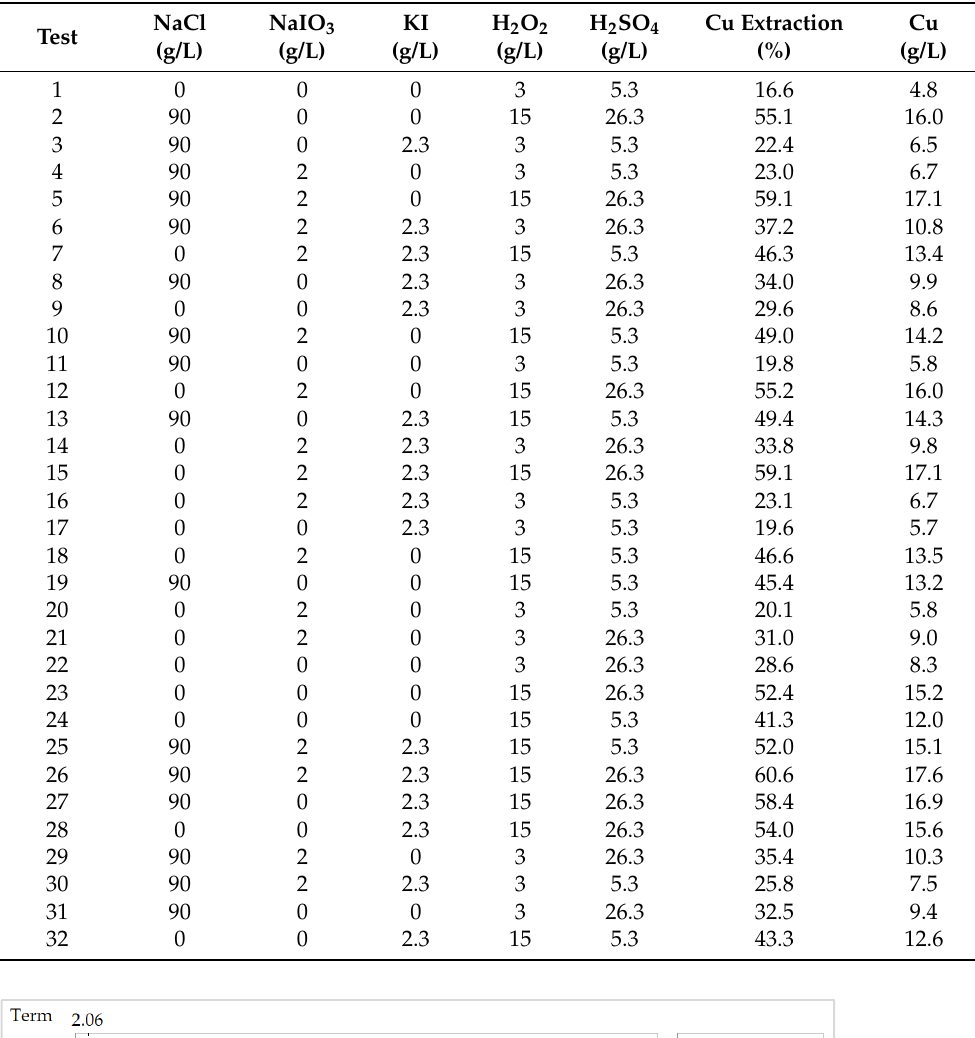
lines that are not horizontal represent an effect on the response. The slopes of the lines represent the magnitude of the effect. Table 5. Results for experiments based on the 2 k factorial design.